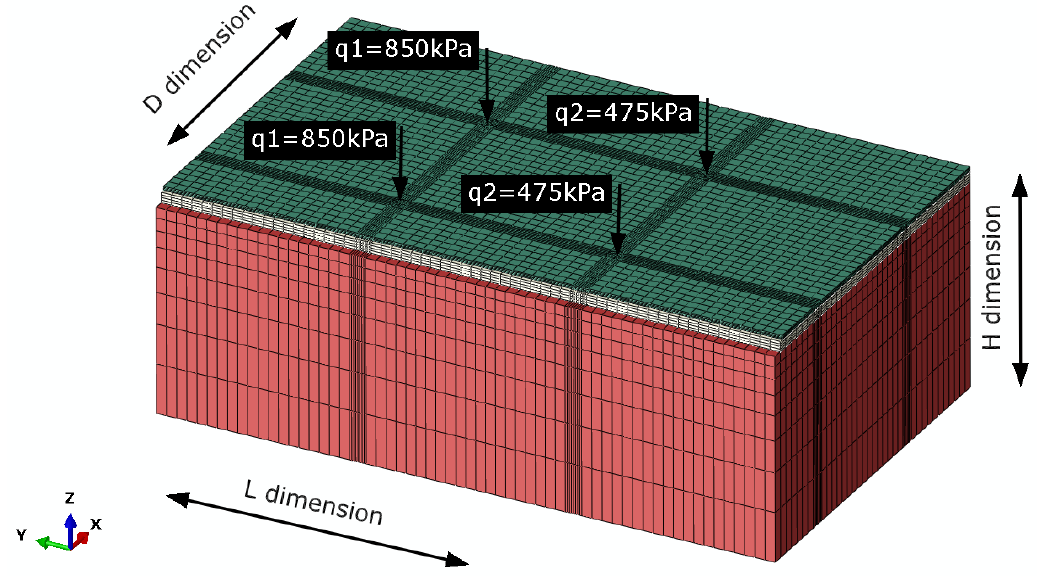
Figure 11. Loading scheme for the structural layers of the trial section; with the assigned FEM mesh. The original dimension of the FEM mesh element, 0.2 × 0.2 × 0.2 m, was reduced to 0.04 × 0.04 × 0.04 m for the interface. The H dimension of the JENA and CRM-FB_5C layers was split into four parts adding up to the thickness of each layer (volumetric elements).